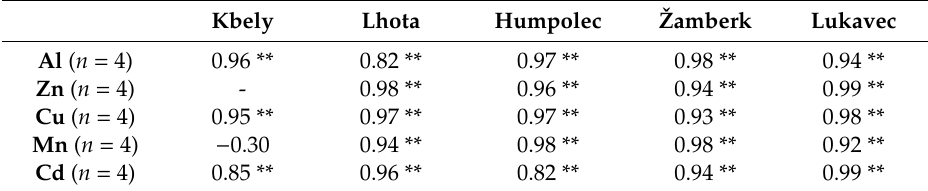
Figure 1. E ff ect of biochar addition on soil-available content of Al (mg kg − 1 ). On the horizontal axis, 1 and 12 stand for 1st and 12th week of incubation period or sample collection time, respectively. Di ff erent capital case letters represent significance di ff erence ( p < 0.05) of treatments within same sample collection time of same soil. Table 2. Pearson correlation coefficient of available Al content with soil pH, CEC, and exchangeable Ca 2+ and K + after addition of four levels of biochar (0.5, 2, 4, and 8%) at the 12th week of incubation. Table 3. Pearson correlation coe ffi cient of percentage change in the available content of Al, Cu, Zn, Cd, and Mn (content in the control subtracted from biochar treatments) in individual soils with the percentage of change in DOC.